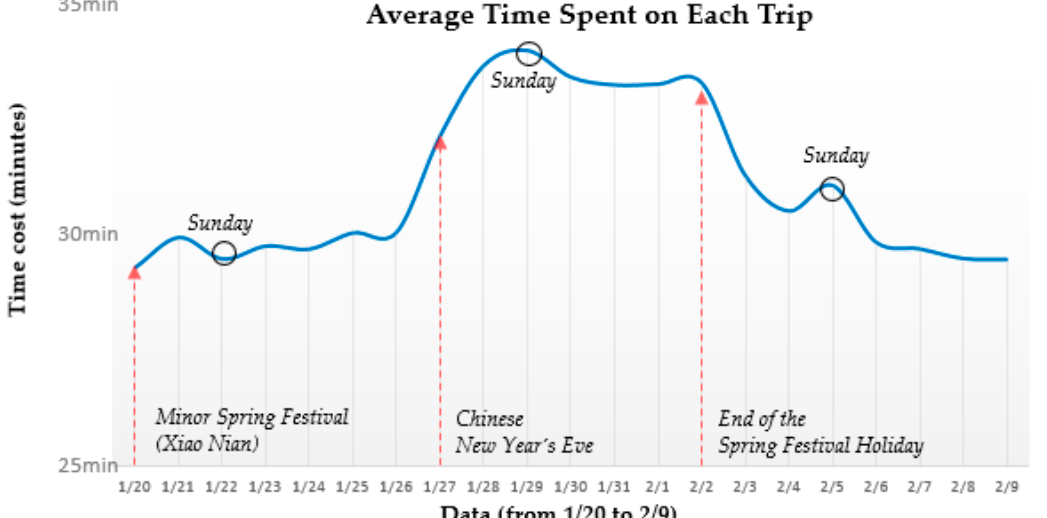
Figure 9. Daily average time spent on each trip of 21 days.